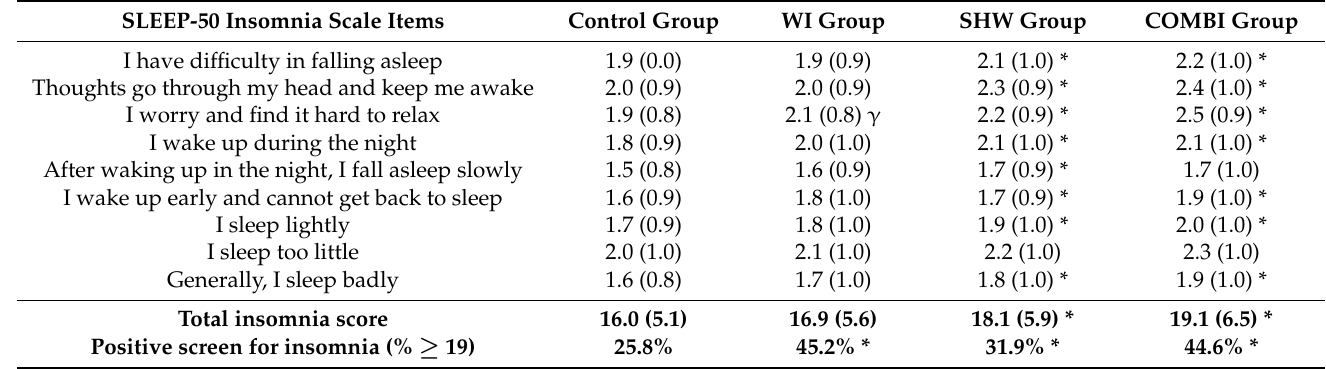
Table 3. SLEEP-50 insomnia scale item scores.